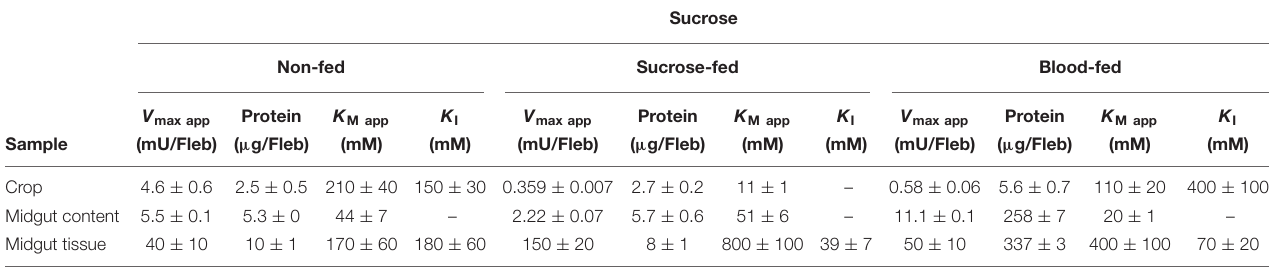
TABLE 2 | Kinetic parameters of α -glucosidase activities obtained from different samples of L. longipalpis females under different physiological conditions, using sucrose as substrate.